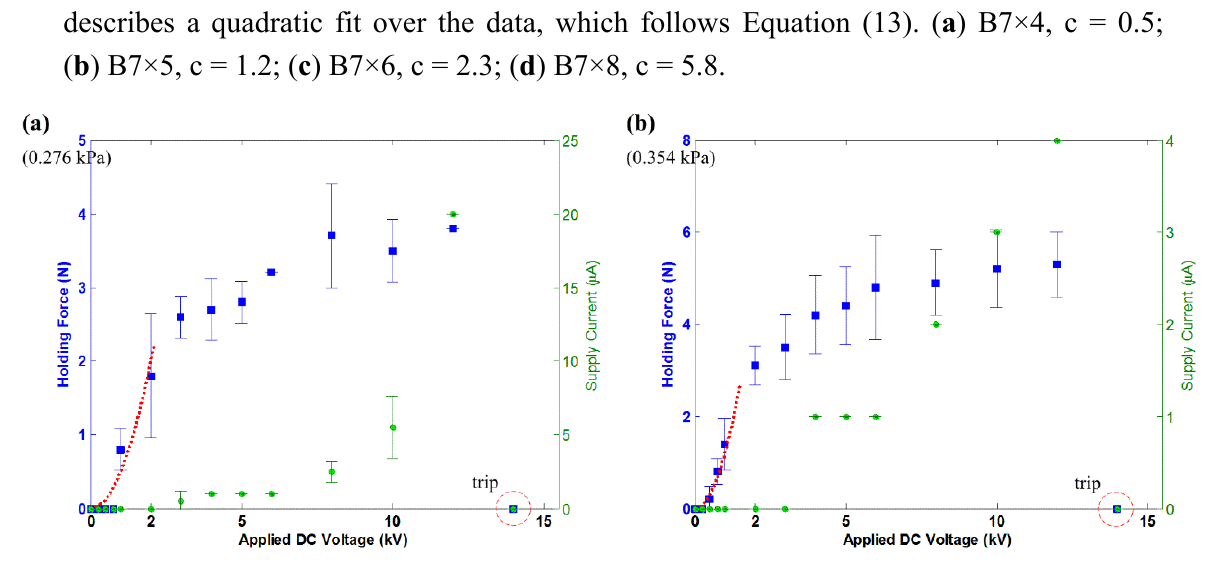
Figure 10. The measured holding force and supply current for the electroadhesion actuators on the concrete slab, shown with the tripped voltage level. The dashed line describes a quadratic fit over the data, which follows Equation (13). ( a ) B7×4, c = 0.5; ( b ) B7×5, c = 1.2; ( c ) B7×6, c = 2.3; ( d ) B7×8, c =